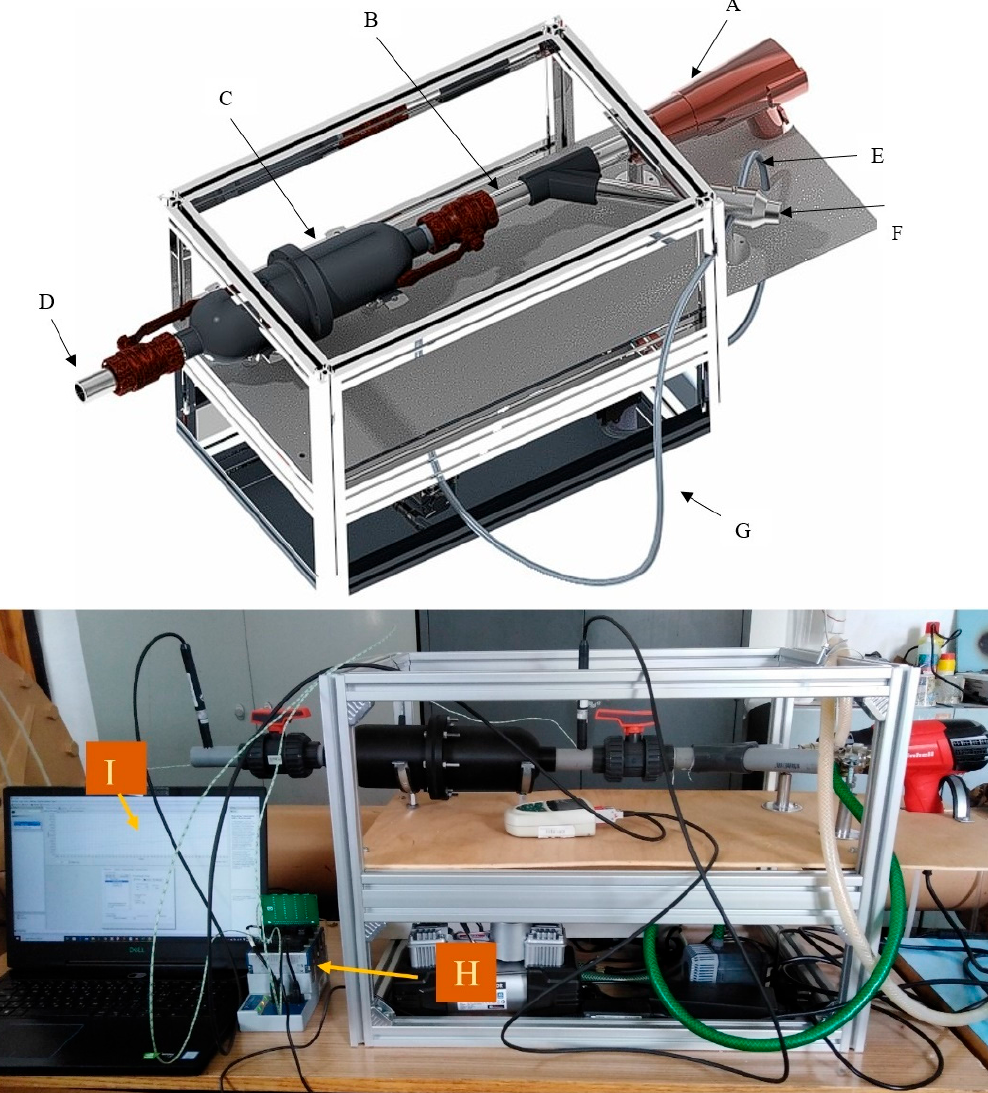
Figure 2. Top : Depicts the 3D outline of (A) the experimental prototype heat gun, (B) the upstream duct, (C) the sorption tube, (D) the downstream duct, (E) the connection to the pump, (F) the atomizer, and (G) the connection to the compressor. Bottom : (H) The data acquisition device, and (I) the computer.